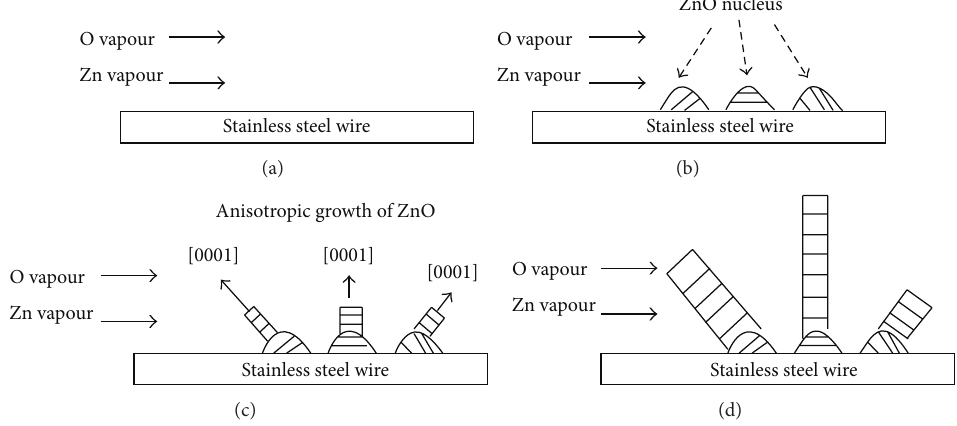
Figure 10: VS growth of ZnO NRs on stainless steel wire: (a) condensation of Zn and O vapours, (b) formation of ZnO nucleus, (c) anisotropic growth of ZnO nucleus, and (d) formation of ZnO NRs on stainless steel wire.